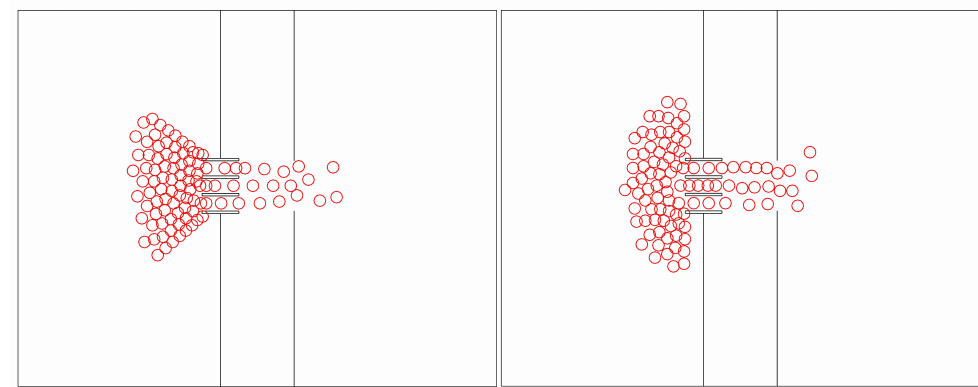
Figure 5. The snapshots of the evacuation process with the passage number being 3. The circles in the figure represent the pedestrians. ( Left ): With invisible walls. ( Right ): Without invisible walls.